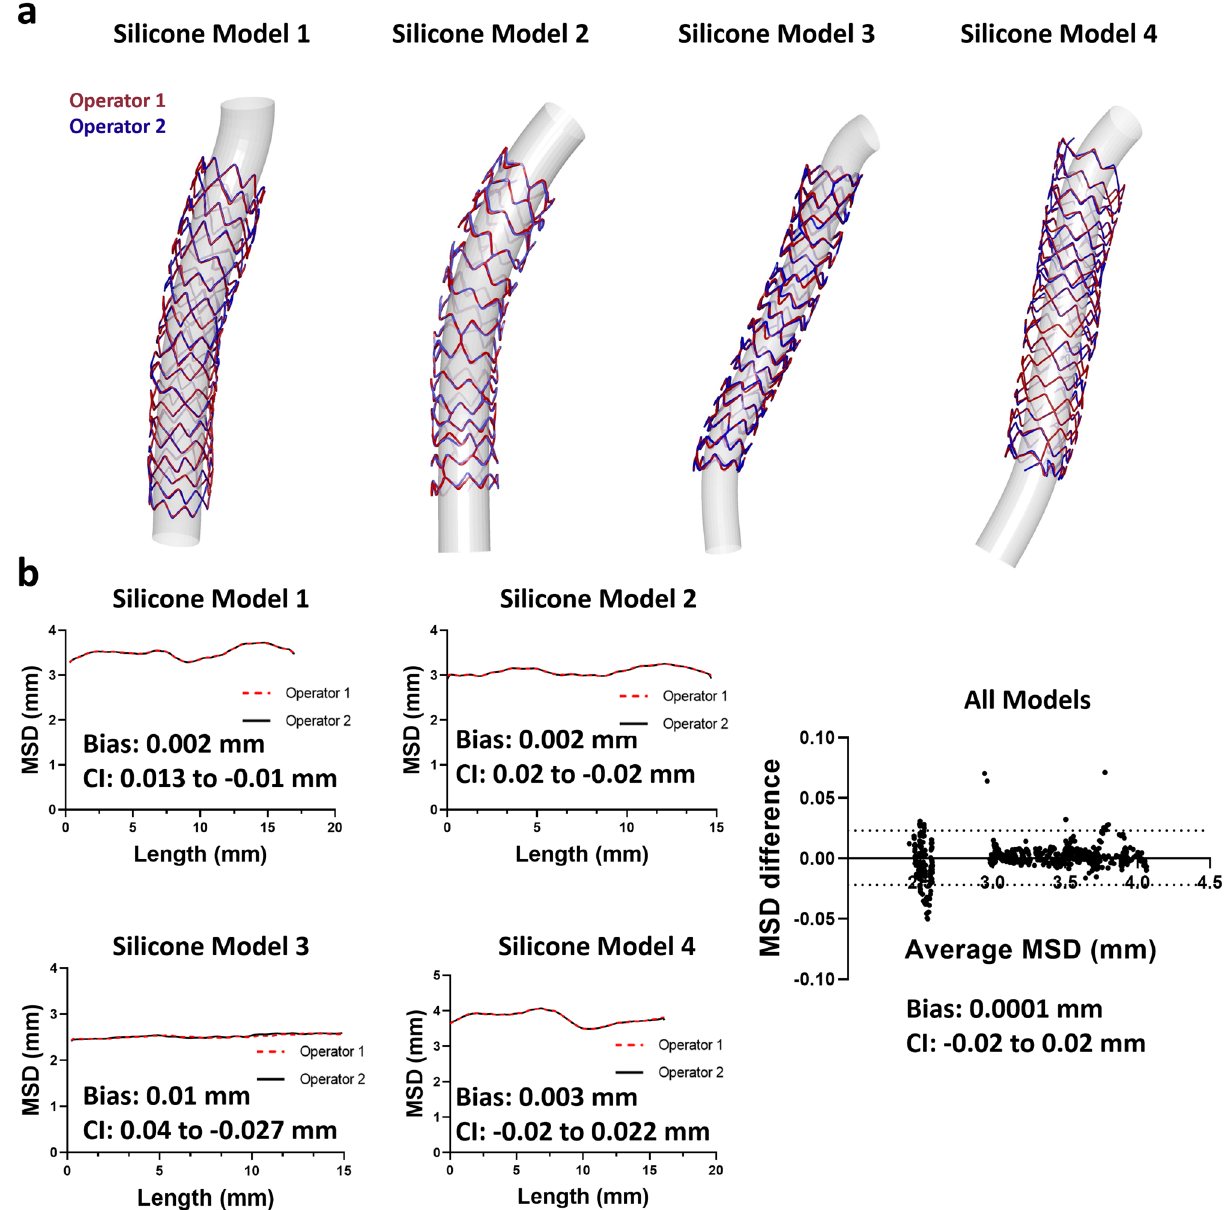
Figure 6. Inter-observer reproducibility of OCT-stent reconstructions. (a) Qualitative agreement by overlapping the two reconstructed stents. (b) Quantitative agreement for each model (MSD, mean stent diameter) and overall agreement using Bland–Altman